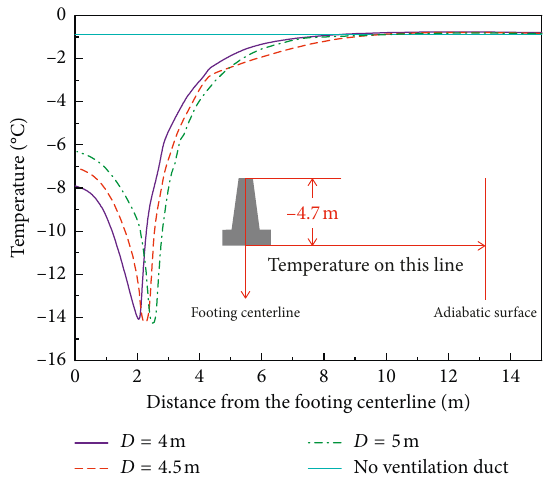
Figure 13: Horizontal temperature distribution at a depth of − 4.7m.